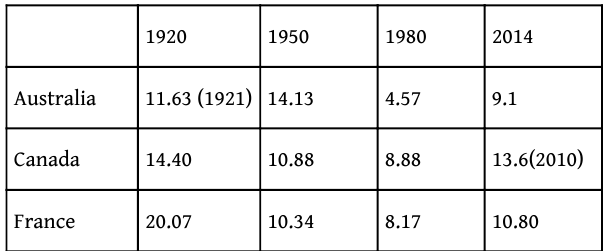
Table 4: Pre-Tax National Income Share of Top